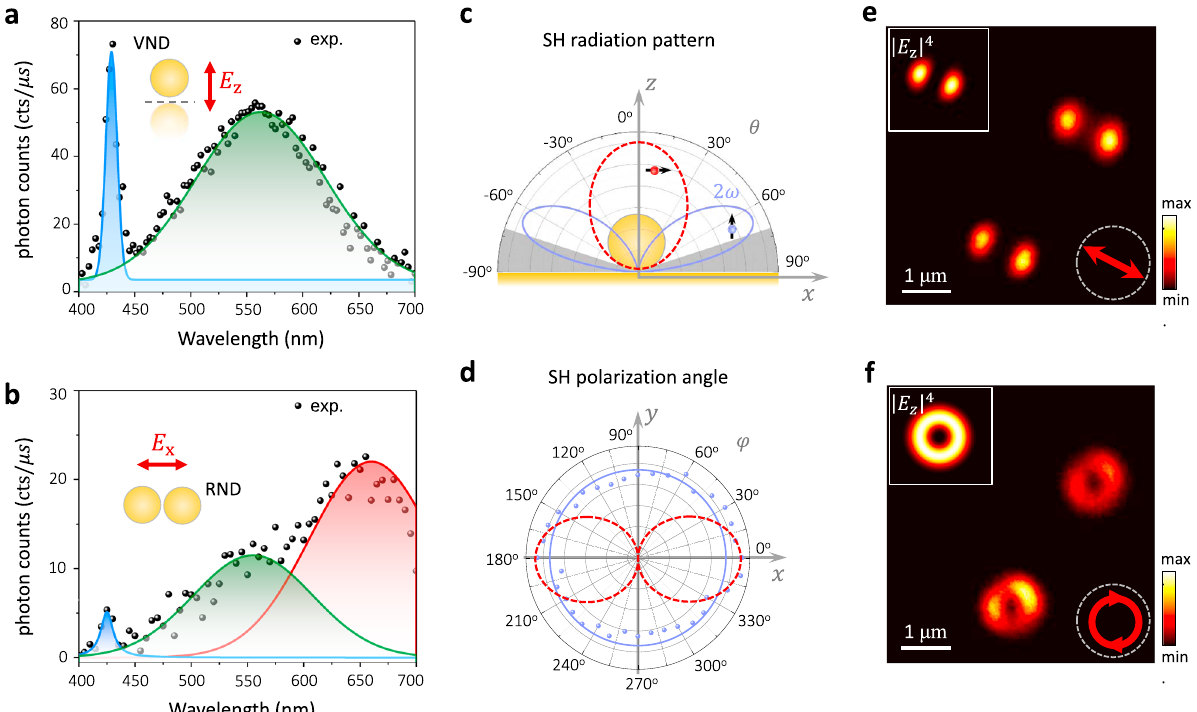
Fig. 4 Characterization of SHG from individual nanosphere dimers. a , b Emission spectra of the VND ( a ) and the RND ( b ) labeled by solid squares in Fig. 3c. The solid lines are fi ttings to the SHG (blue) and TPL (green and red) spectra, respectively. The two TPL peaks in ( b ) are related to two resonances observed in the scattering spectrum (Fig. 1e). c Calculated SHG radiation pattern of a single VND (blue) and a comparison to the SHG radiation pattern of a horizontal electric dipole above a silica substrate, emulating an RND (red). d Measured (blue dots) and simulated (blue line) polar plots of the polarization of the SHG light from an individual VND. The red curve represents the calculated SHG polarization orientation for an RND emulated with an electric dipole. The measured pattern is slightly stretched along x -axis due to the polarization response of the experimental setup. e , f Comparison between the SHG confocal images of the VND scanned using linearly ( e ) and circularly ( f ) polarized fundamental light. Insets show the calculated driving longitudinal fi eld | E 4 in the focal plane. Scale bar in ( e ), ( f ) is 1 μ z |